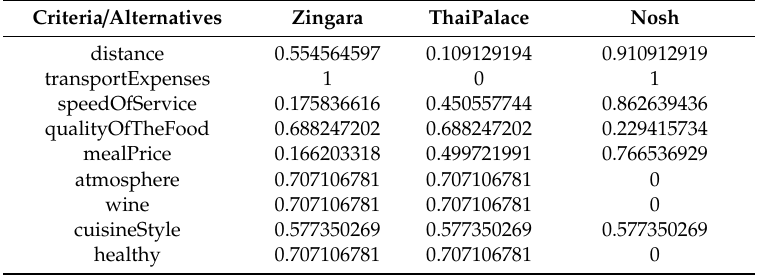
Table 7. Normalized values for each criterion in each alternative on the given example.